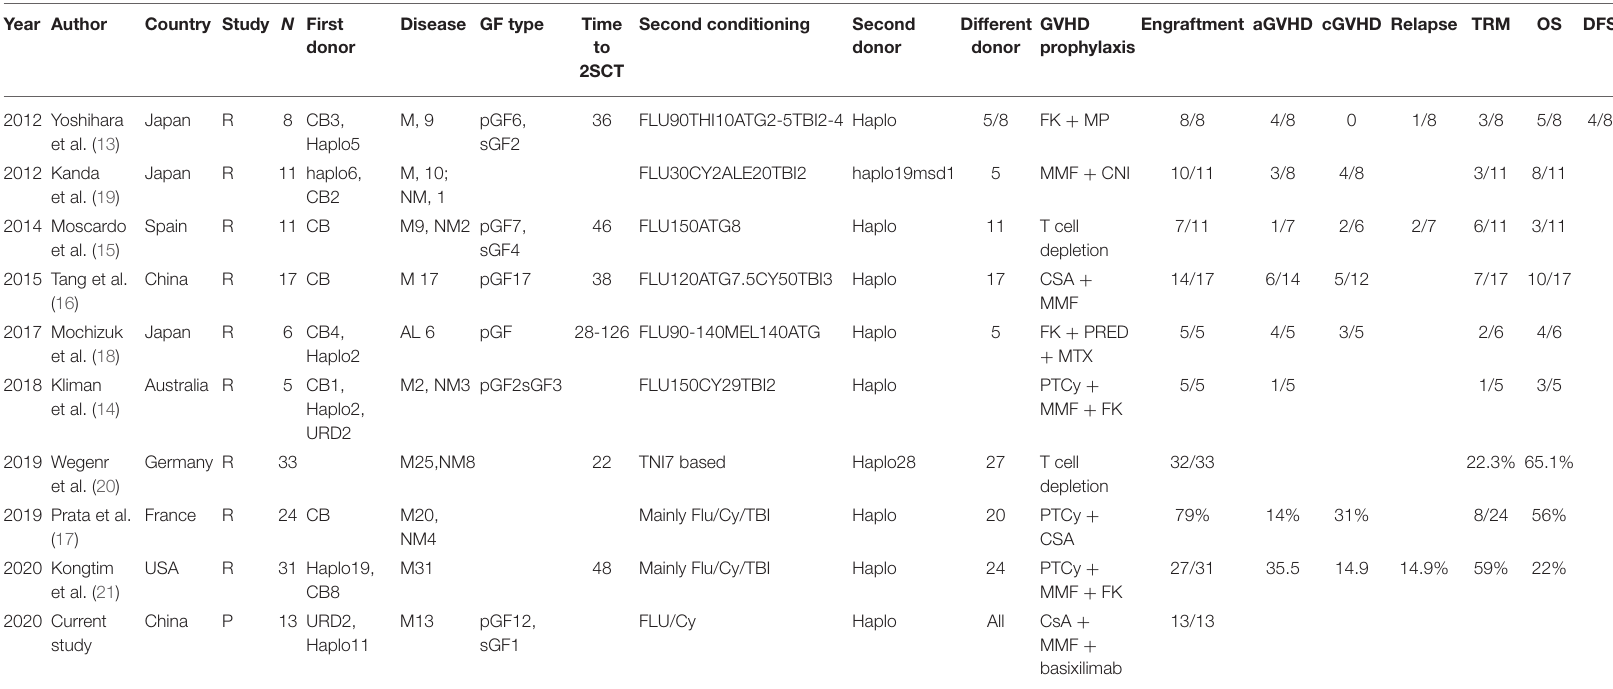
TABLE 3 | Summary of reports utilizing haplo-SCT as salvage for graft